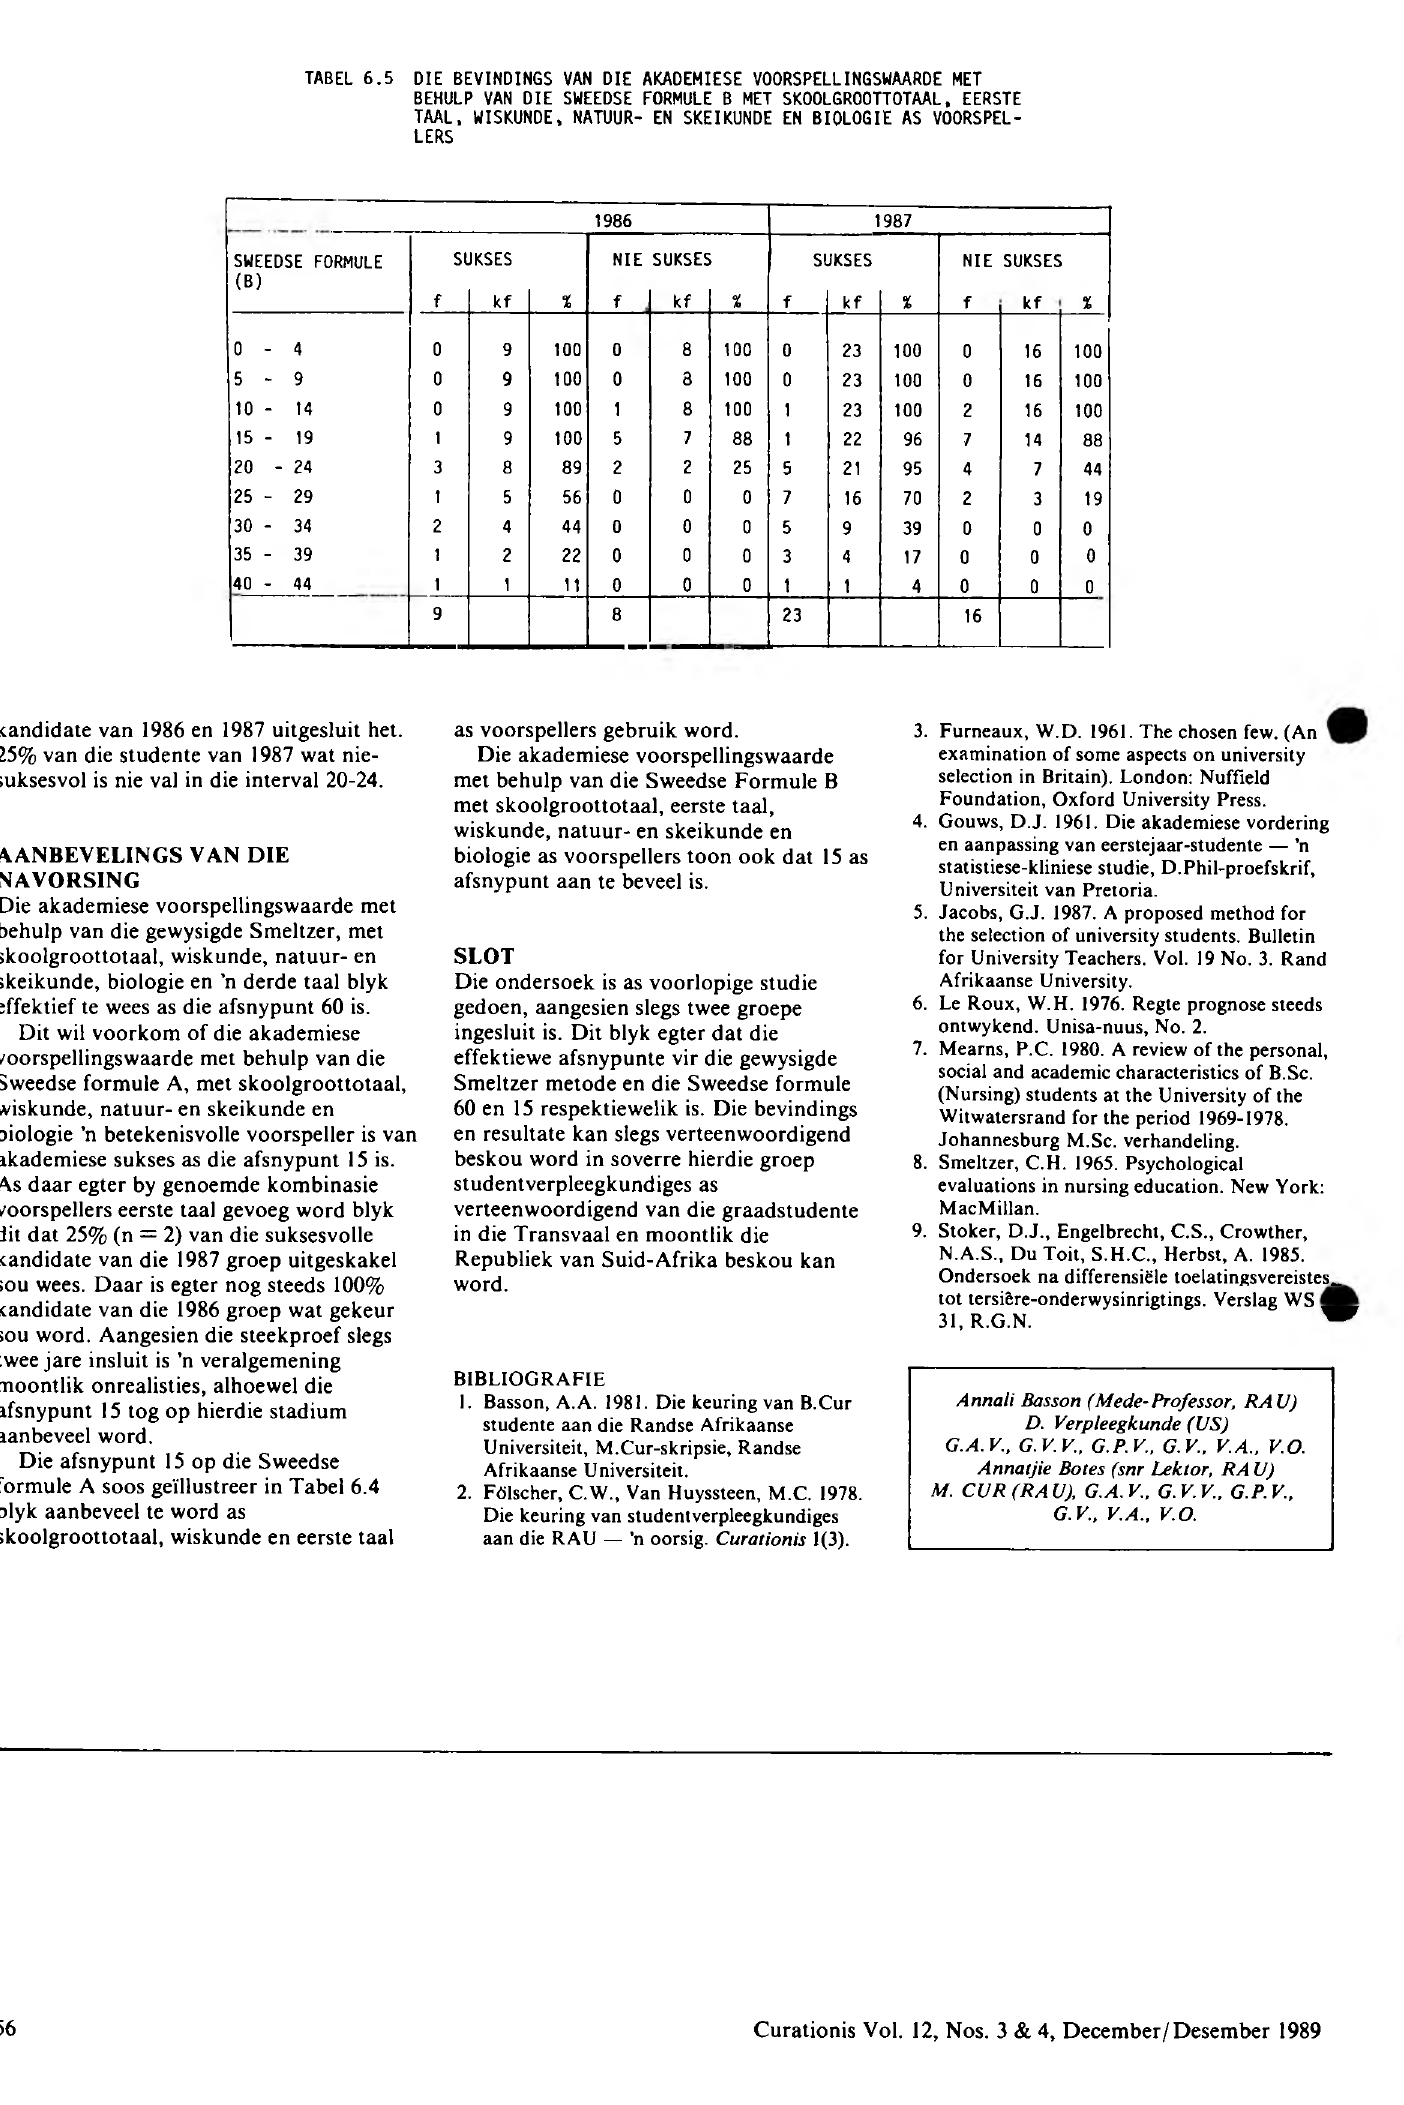
TABEL 6.5 DIE BEVINDINGS VAN DIE AKADEMIESE VOORSPELLINGSWAARDE MET BEHULP VAN DIE SWEEDSE FORMULE B MET SKOOLGROOTTOTAAL,